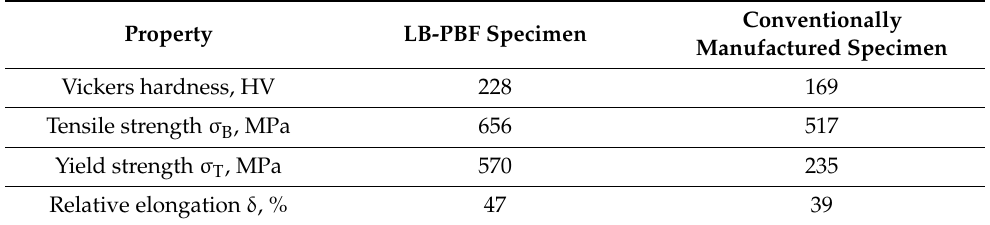
Table 5. Results of the mechanical properties study of the specimens made by the LB-PBF and comparison with the properties of conventionally manufactured specimen of the same steel.